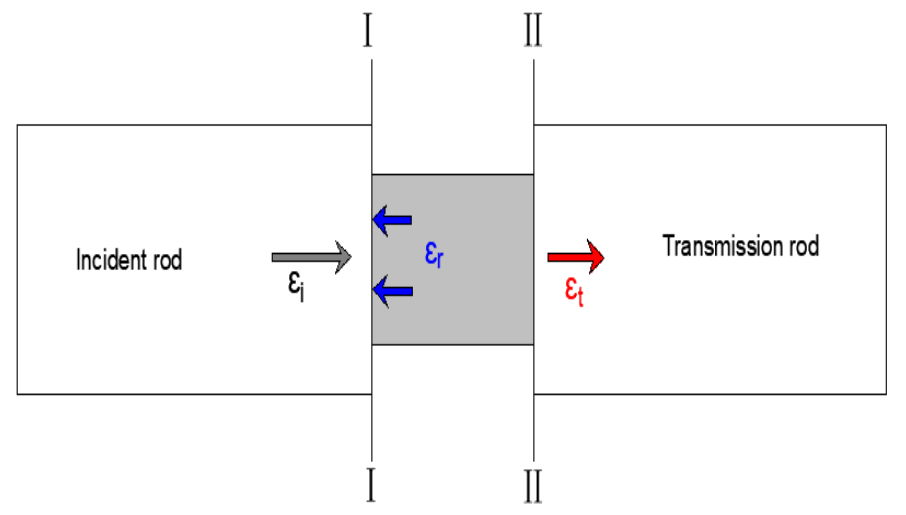
Figure 2. SHPB test principle.